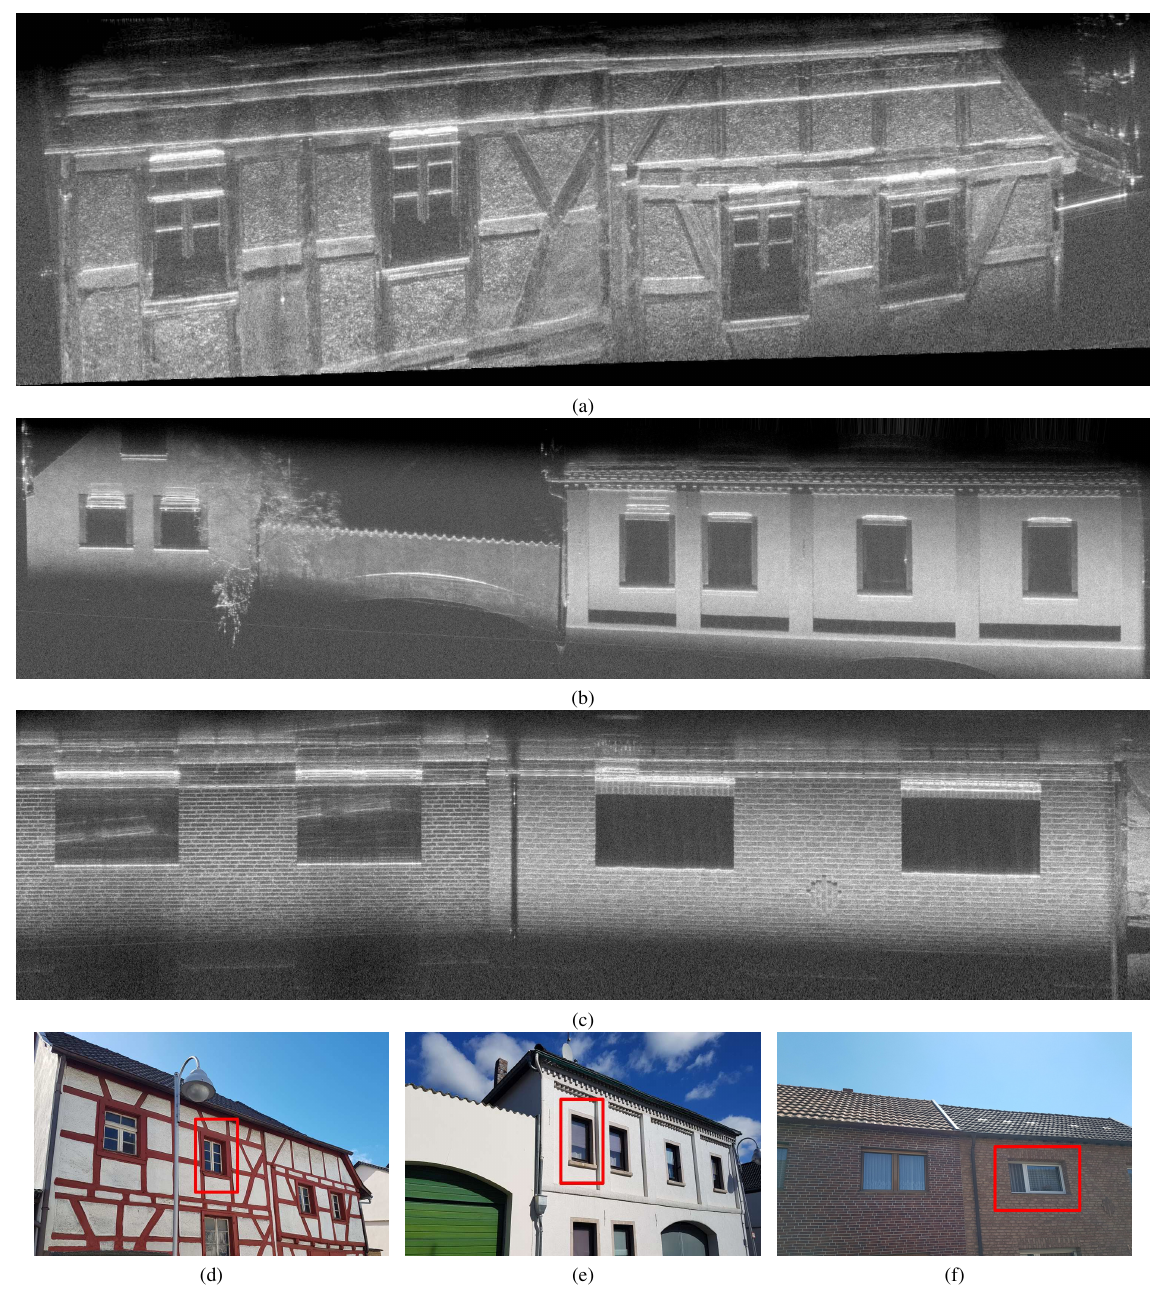
Figure 9. Carborne 300 GHz SAR images of facades with 5 mm resolution. (a) First floor of half-timbered house. The orientation of the facade of the building is slightly offset from focusing plane. Thus, the windows and rain pipe seem to move into the image plane. A very high level of details can be observed. The backscattering characteristic reveals different materials. (b) First floor of two adjoining houses with more homogenous wall plaster connected with an archway. A tree is standing in front of the left facade. (c) Brick facade of two adjoining houses with slightly different orientation. (d) Photograph of half-timbered house. (e) Photograph of 2 adjoining houses. (f) Photograph of brick